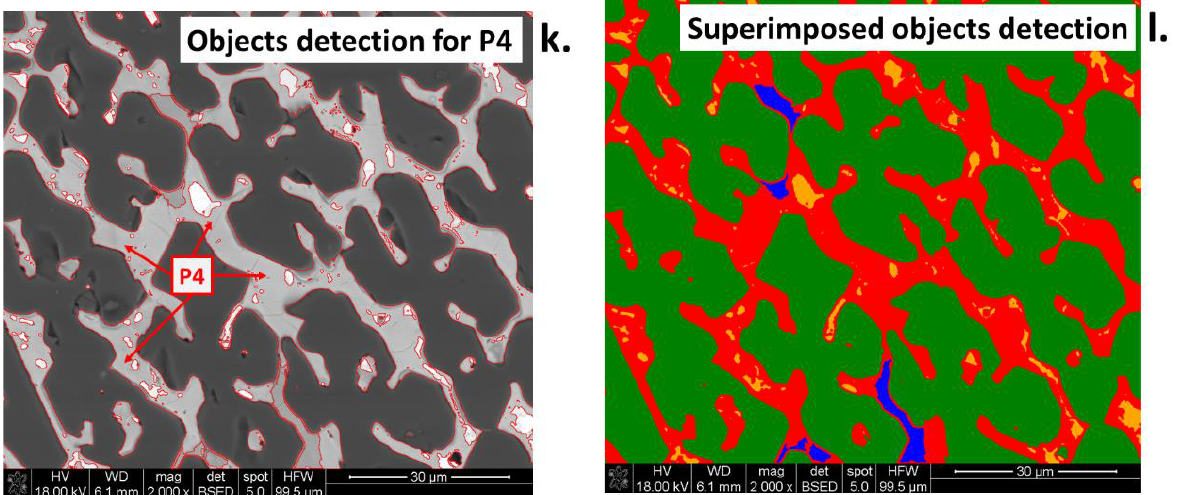
Figure 15. ( a – l ) Images presenting the steps of the algorithm for image analysis of high-temperature ceramic material.